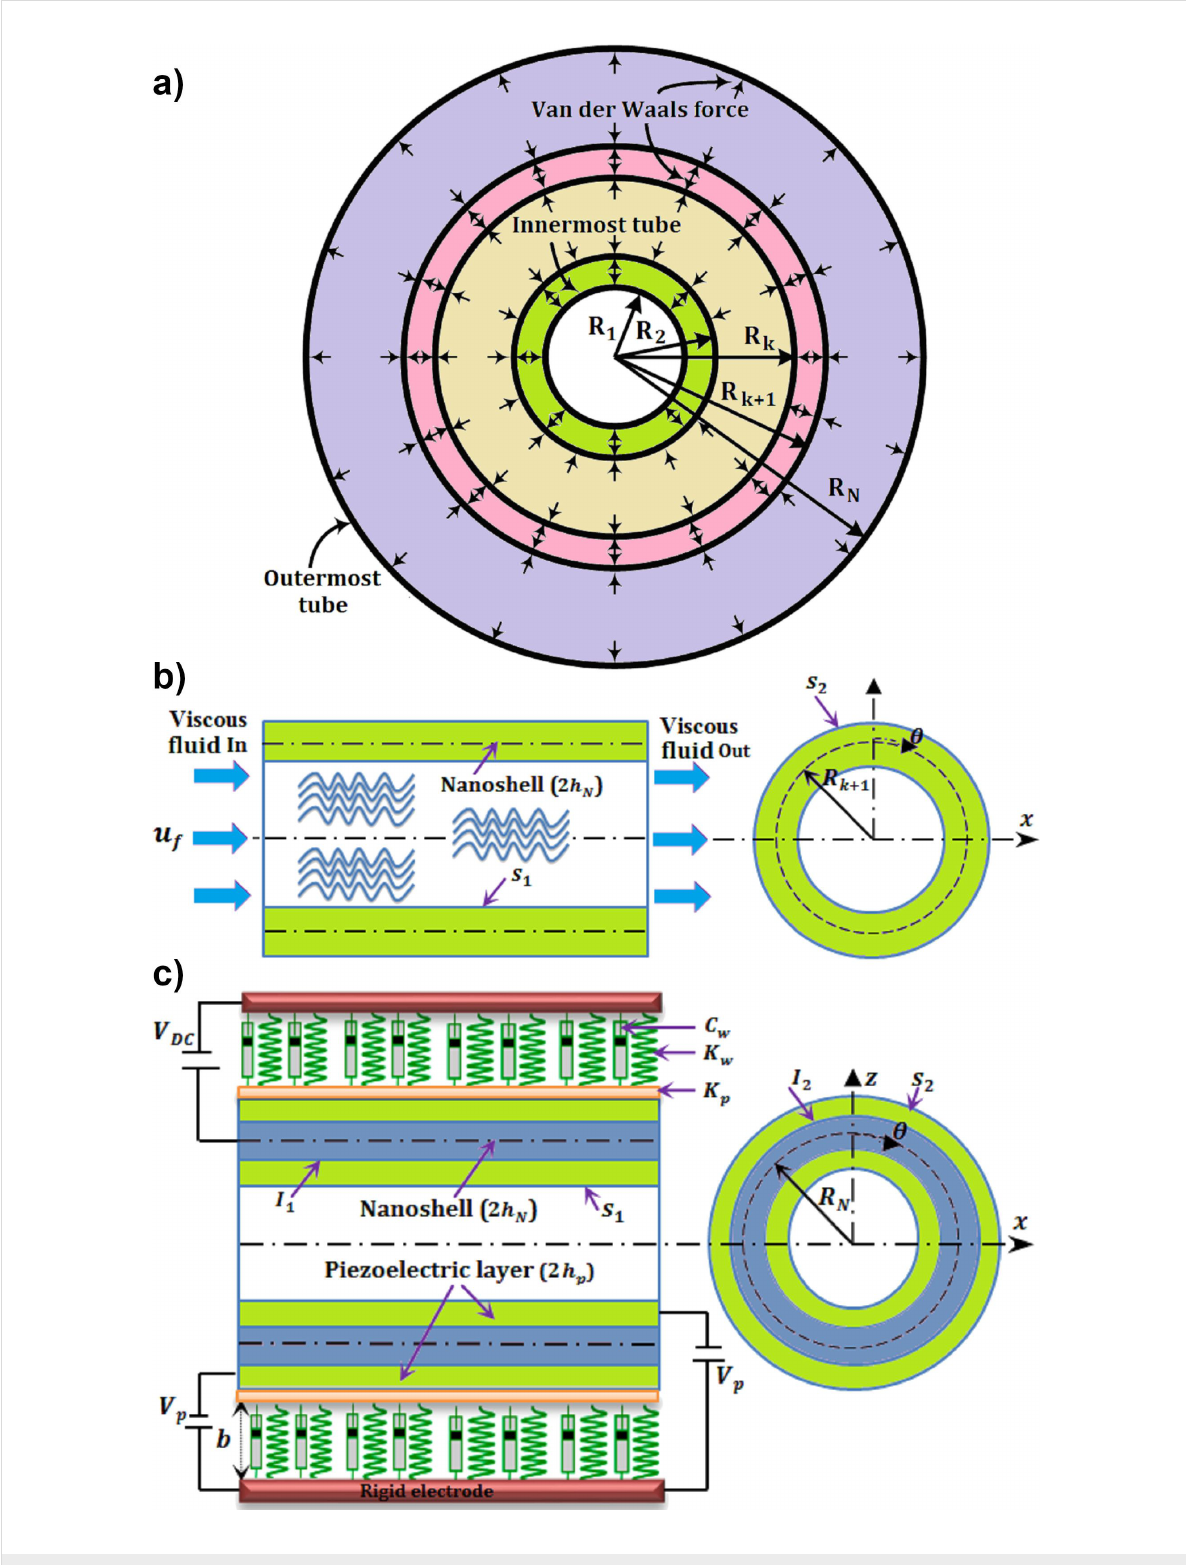
Figure 1: Fluid-conveying multiwalled piezoelectric nanosensor. (a) Illustration of van der Walls forces between two adjacent tubes of a multiple shell cross section of a multiwalled carbon nanotube (MWCNT). (b) Modeling of a 1… k + 1 tube of a MWCNT as a fluid-conveying nanosensor with sur- face model. (c) Modeling of the last tube of a MWCNT as a piezoelectric nanosensor with surface/interface